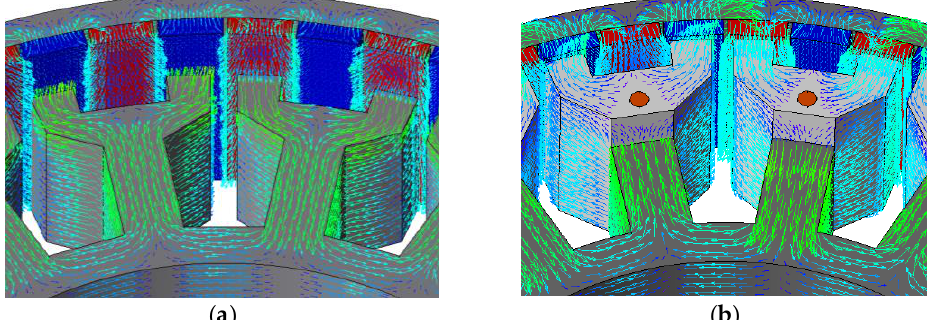
Figure 5. No-load air-gap magnetic flux density. ( a ) 0 mm waveform. ( b ) Air-gap flux density versus axial position. ( c ) 0 mm harmonic distributions.